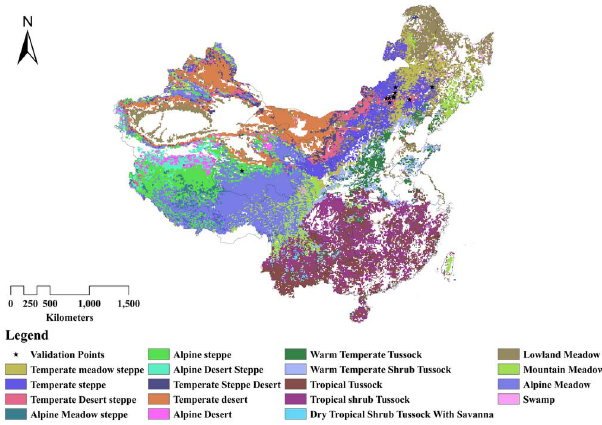
Fig. 1. China’s 18 types grassland distributions, five-pointed stars are model validation